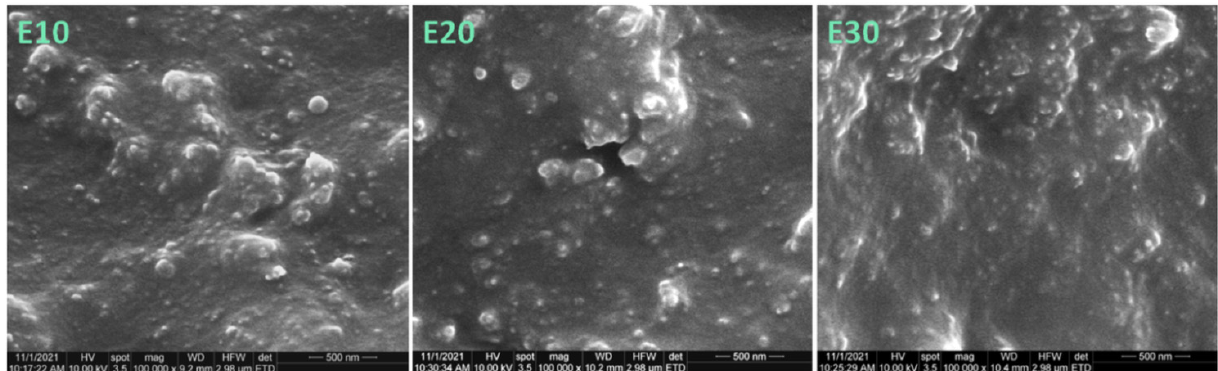
Figure 3. SEM images (×100,000) of cryo-fractured sections of E10, E20 and E30 nanocomposites.